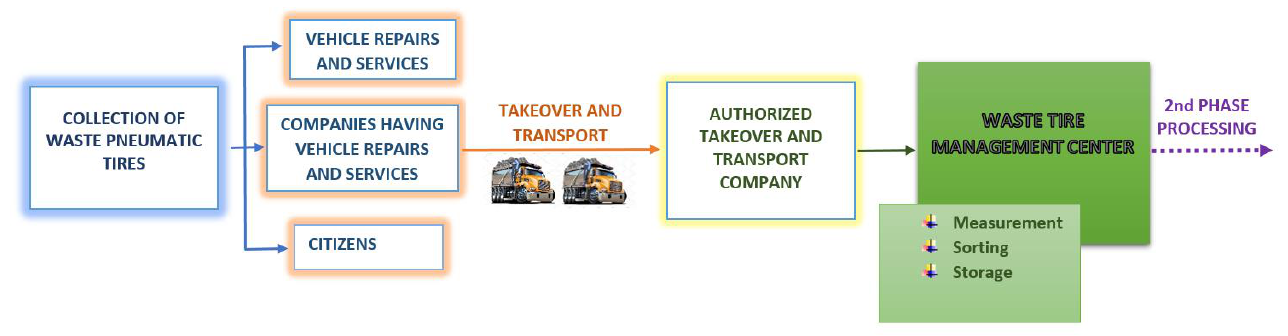
Figure 1. Technological scheme of the first phase of the project.